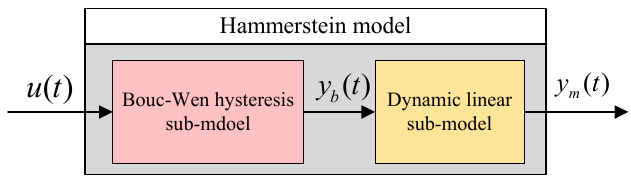
Figure 1. Schematic diagram of the Hammerstein